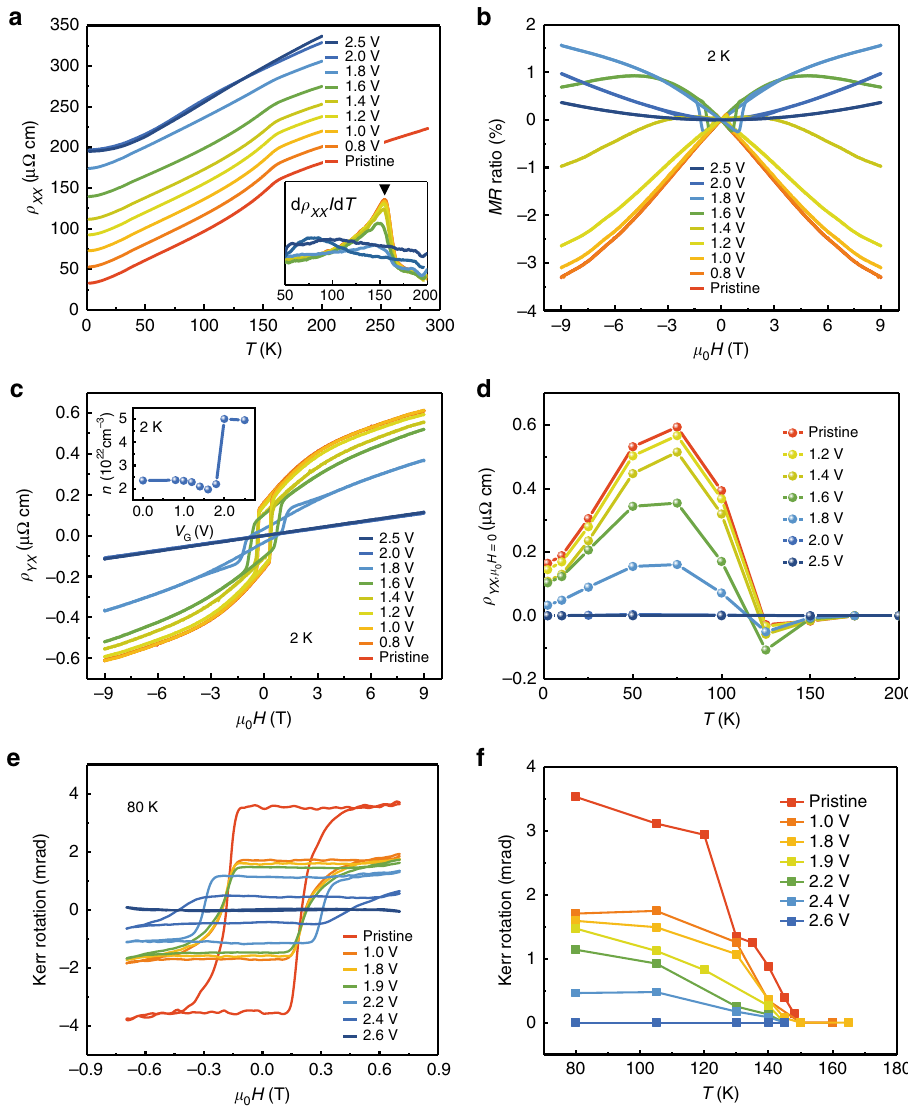
Fig. 2 Magnetic evolution via electrically induced protonation. a Temperature dependent longitudinal resistivity ρ XX at different V G . The inset shows the corresponding differentiate resistivity d ρ XX = d T at different V G . A vertical offset of 20 μΩ cm is applied for each curve for clarity. b Magnetic fi eld dependent magnetoresistance (MR) measured at 2 K with different V G . c Magnetic fi eld dependent Hall resistivity measured at 2 K with different V G . The inset shows the V G dependence of carrier density at 2 K. d Temperature dependent anomalous Hall resistivity obtained at μ 0 H = 0 T with different V G . e Kerr rotation vs. magnetic fi eld results measured at 80 K with different V G . f Kerr rotation as a function of temperature obtained at μ 0 H = 0 T with different V G . The slightly varied threshold gate voltages among transport, MOKE and XRD measurements are attributed to the different device con